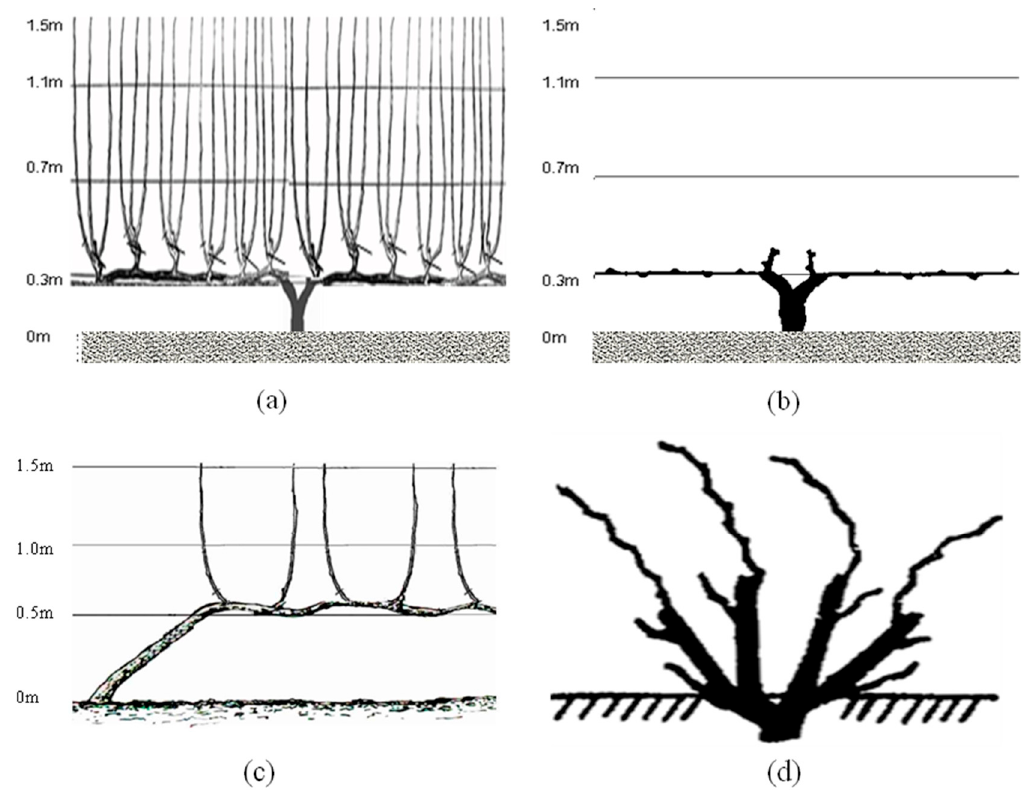
Figure 2. Diagram of vines under the “crawled cordon training” (CCT) training system before pruning in winter ( a ) and after pruning in winter ( b ); diagram of independent long-system pruning (ILSP) ( c ) [28]; diagram of multiple cordons fan-training (MVF) ( d ).